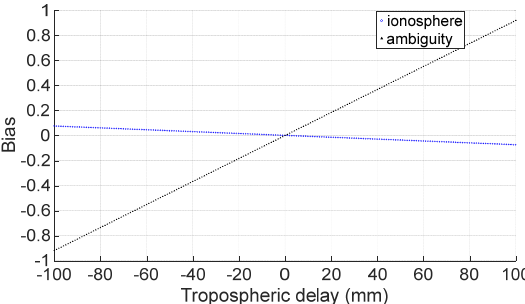
Figure 10. Effect of tropospheric delay on narrow ‐ lane ambiguity resolution.